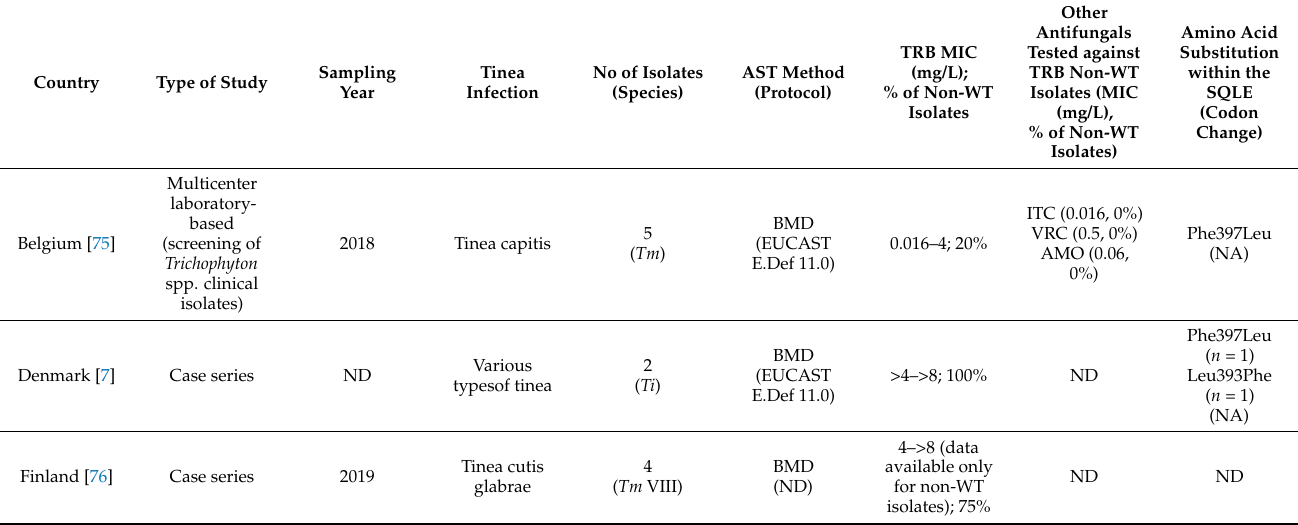
Figure 4. Global distribution of T. interdigitale / T. mentagrophytes isolates exhibiting reduced susceptibility to terbinafine (detailed in Table 4). The country of origin is colored in red, while the type of study (case report: CR, case series: CS, single-center study: SS, multicenter study: MS) along with the recovery rate of isolates displaying non-wild-type (WT) phenotype, terbinafine minimum inhibitory concentrations (mg/L) and amino acid positions with hot-spot mutations in the squalene epoxidase target gene (where available) are presented. Table 4. Global distribution of T. interdigitale / T. mentagrophytes clinical isolates exhibiting reduced susceptibility to terbinafine.